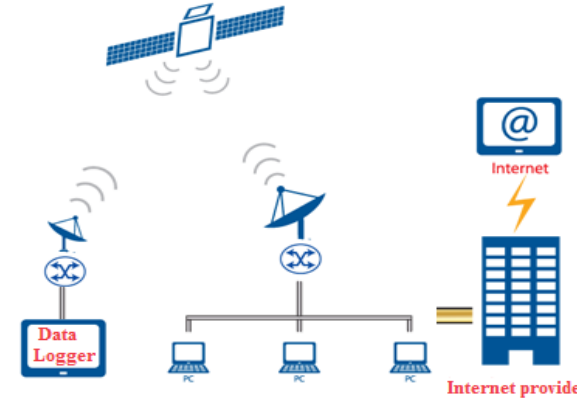
Figure 3. Scheme of field data transmission through